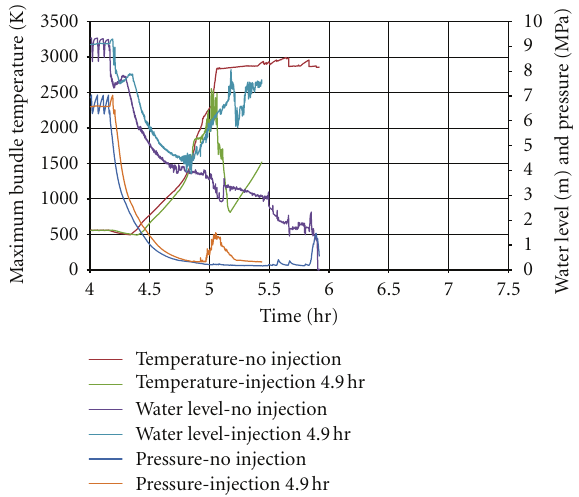
Figure 34: Maximum bundle temperature, water level, and reactor vessel pressure for scenarios without water injection and with water injection at 4.9 hours after scram (all emergency water injection was terminated at 4.2 hours after reactor